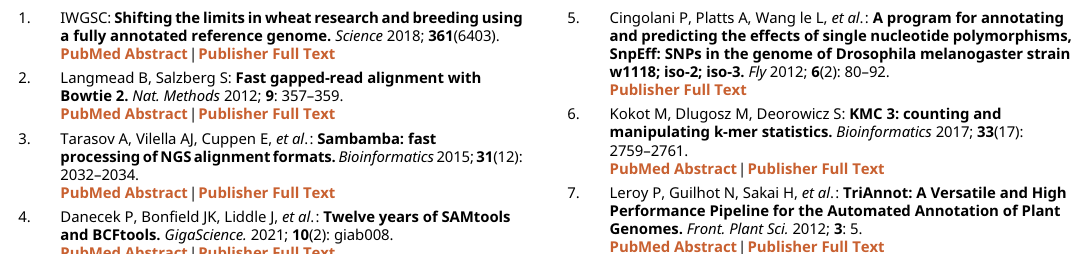
Figshare: Sonmez_Extended_Data3, https://doi.org/10.6084/m9.figshare.16992388.v2.